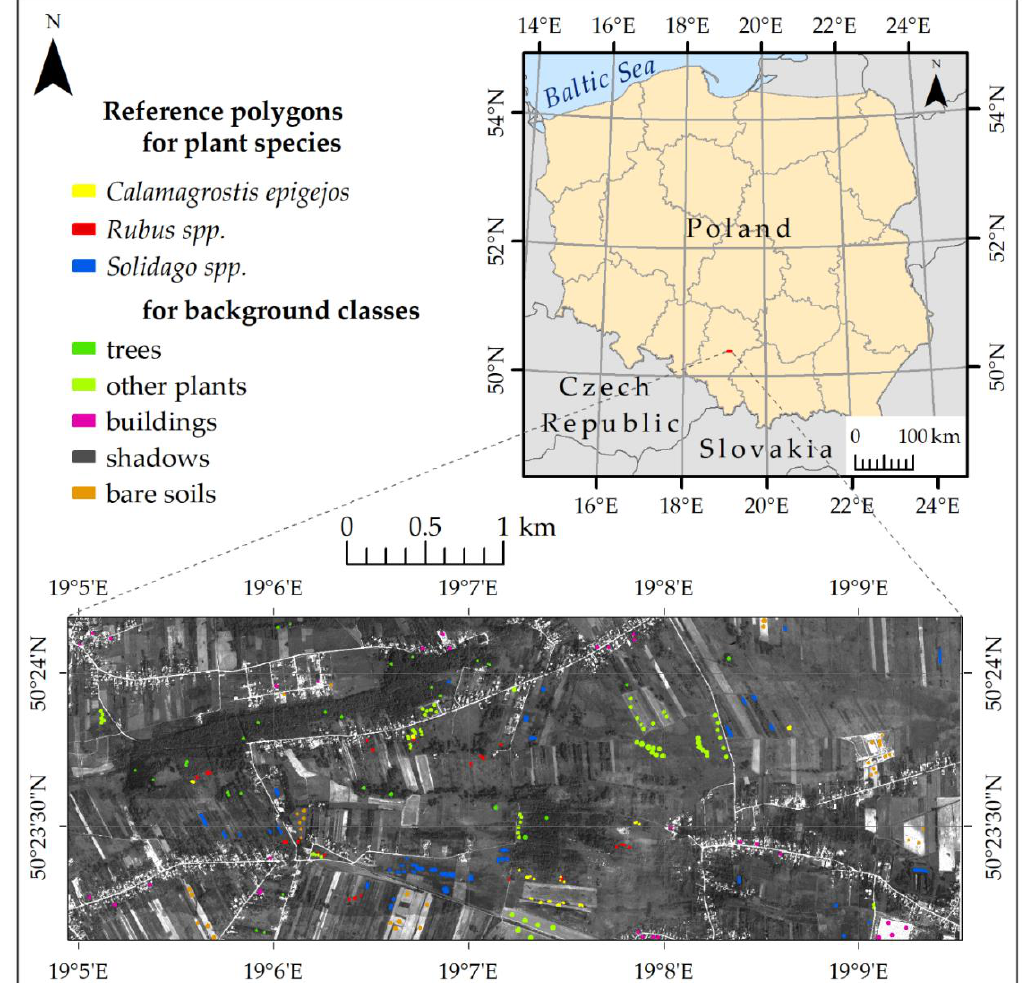
Figure 1. Field research polygons on the Malinowice area.